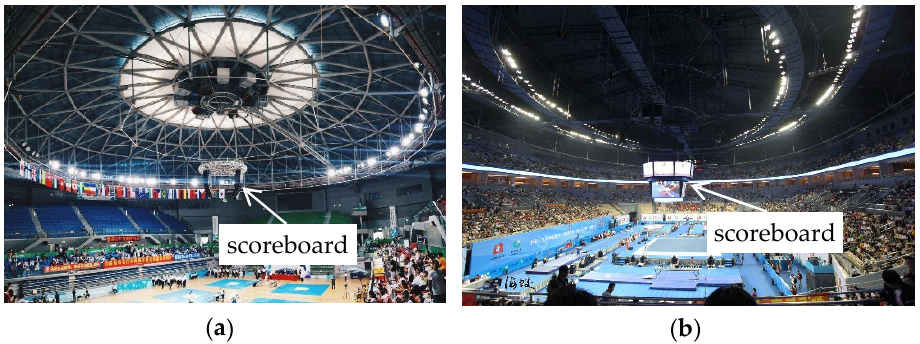
Figure 2. Suspen-dome structure with center-hung scoreboard: ( a ) Pingshan Basketball Gymnasium; ( b ) Dalian Gymnasium.